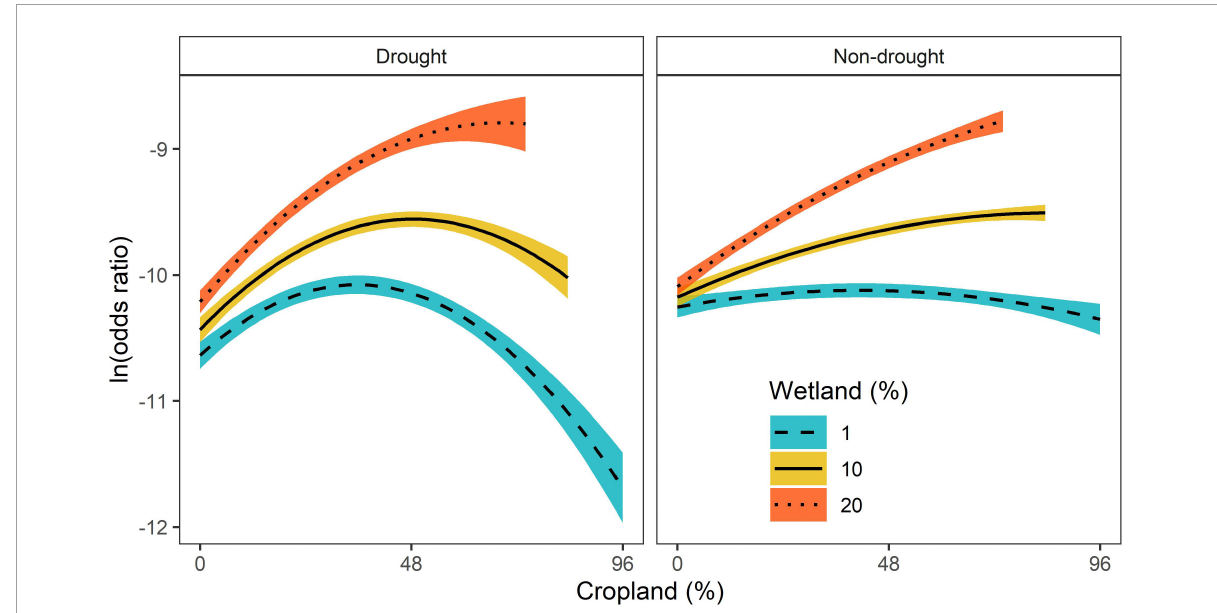
FIGURE2 Predicted log odds ratios and 95% credible intervals of relative probability of use by whooping cranes ( Grus americana ) for percentage of cropland and wetland within 800-m radius during drought and non-drought conditions. All other variables in the model were held at their mean values. Prediction curves for 10 and 20% wetland were removed when cropland was > 90 and 80%, respectively, as to not exceed